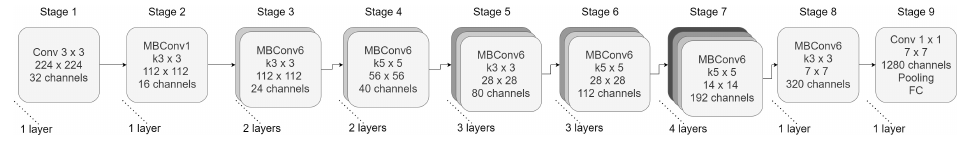
Figure 17. EfficientNet-b0